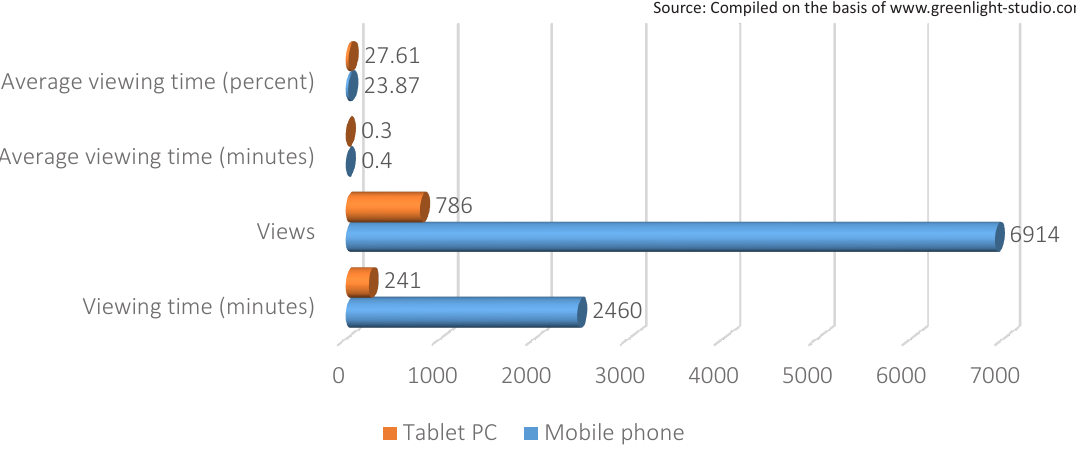
Figure 7. Analysis of length of viewing a video clip for 21 days for mobile phones and tablet